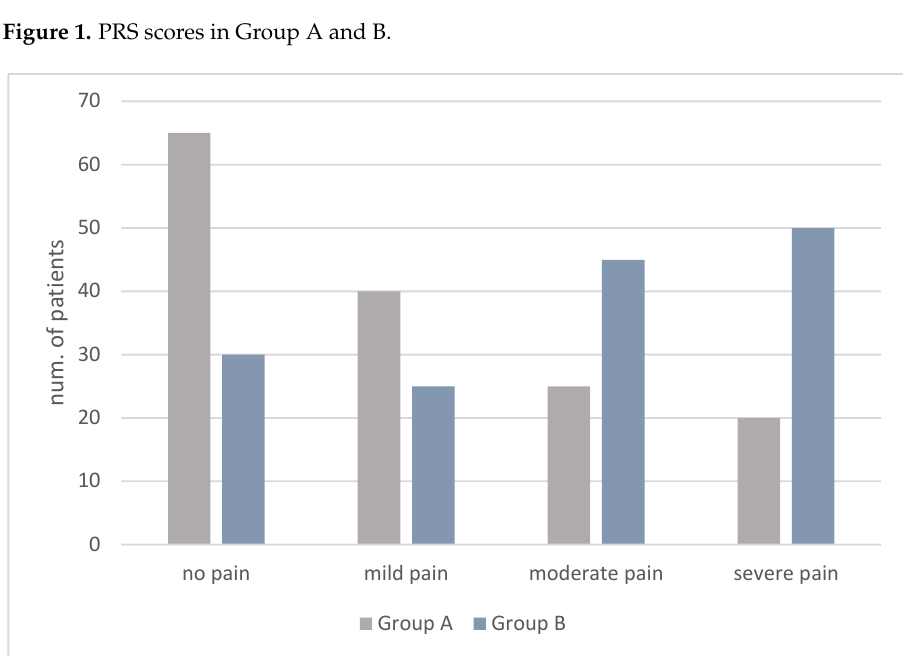
Figure 2. FLACC scores in Group A and B.